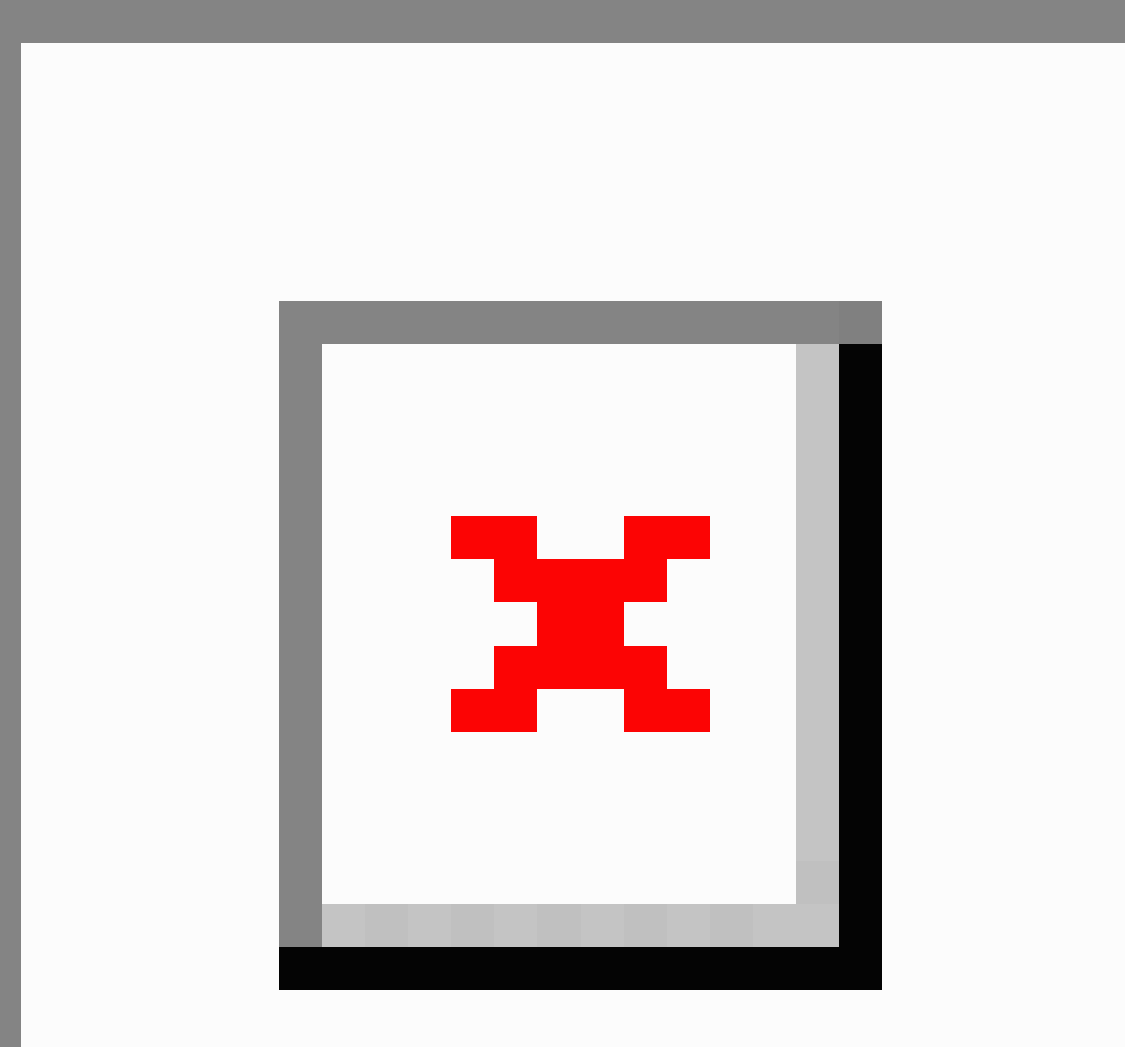
Figure 3. Bland-Altman plots showing the differences in reported systolic blood pressure (SBP) and diastolic blood pressure (DBP) between the 3 Web-based questionnaires and the obstetric record plotted against the mean of the 2 methods of data collection. Each data point shows one participant. The short dashed line shows the mean difference. The long dashed lines show the 95% limits of agreement (mean difference ±2